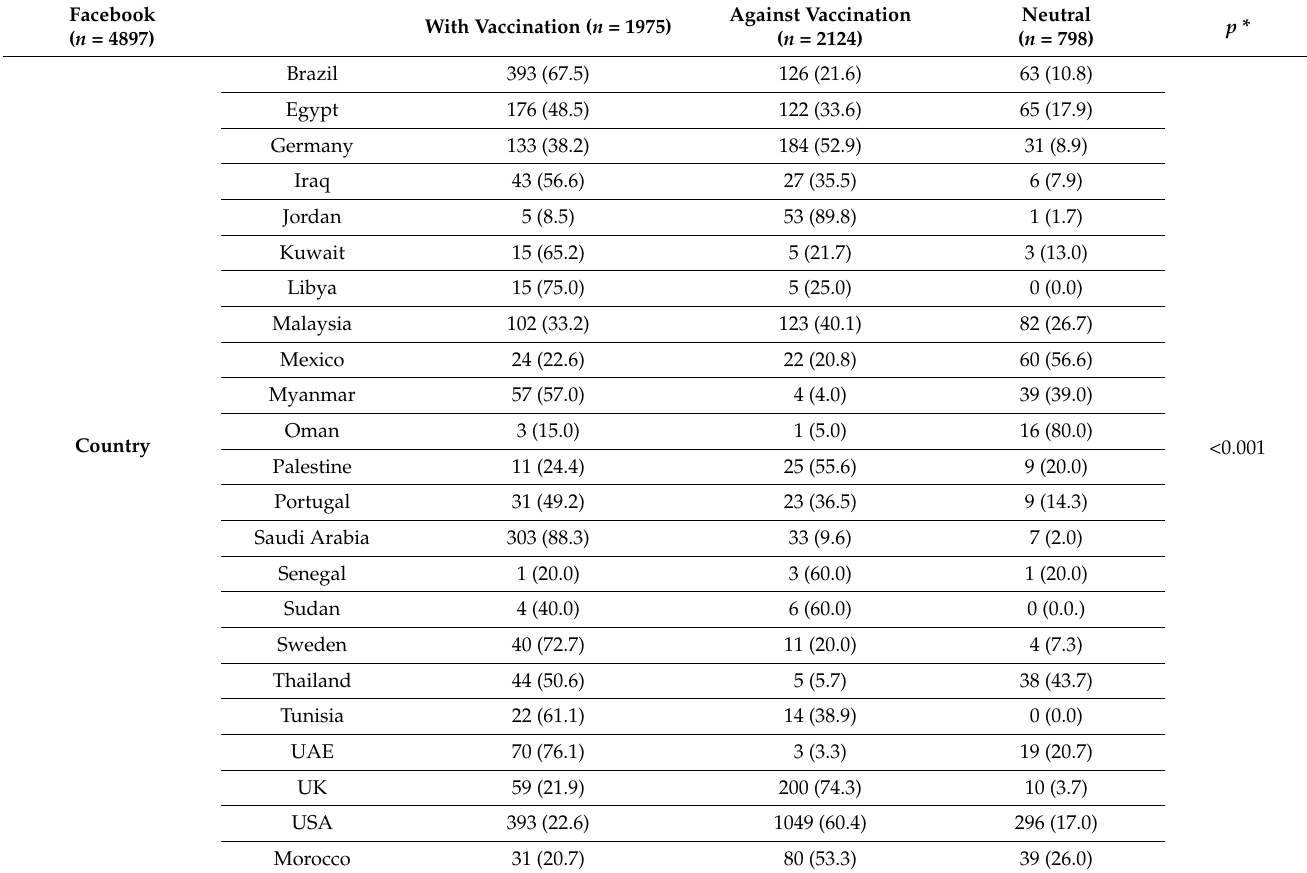
Table 1. Country-position toward COVID-19 vaccination in Facebook and